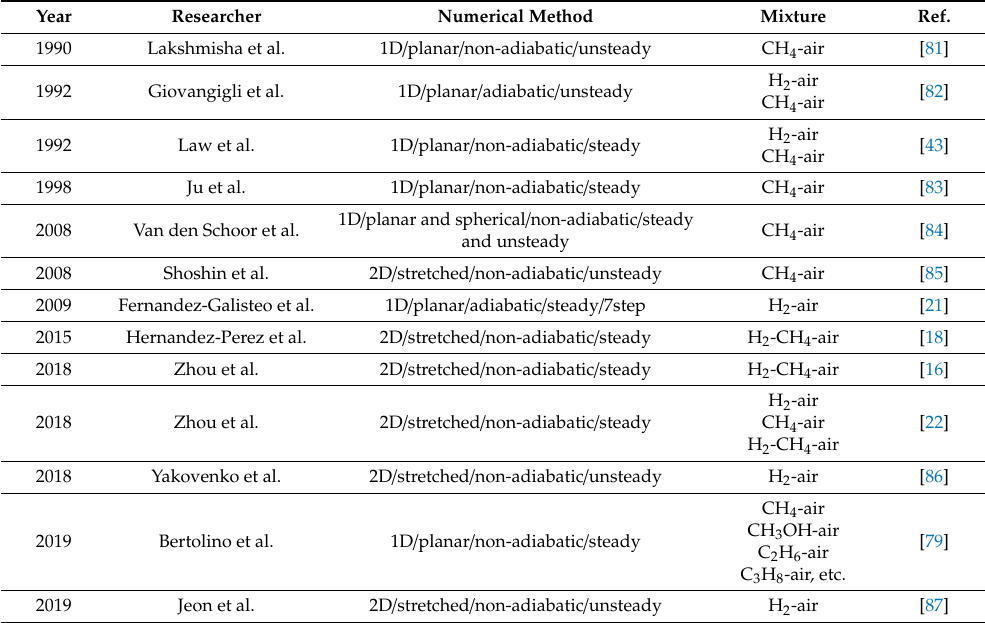
Table 6. Summary of numerical studies to investigate the flammability